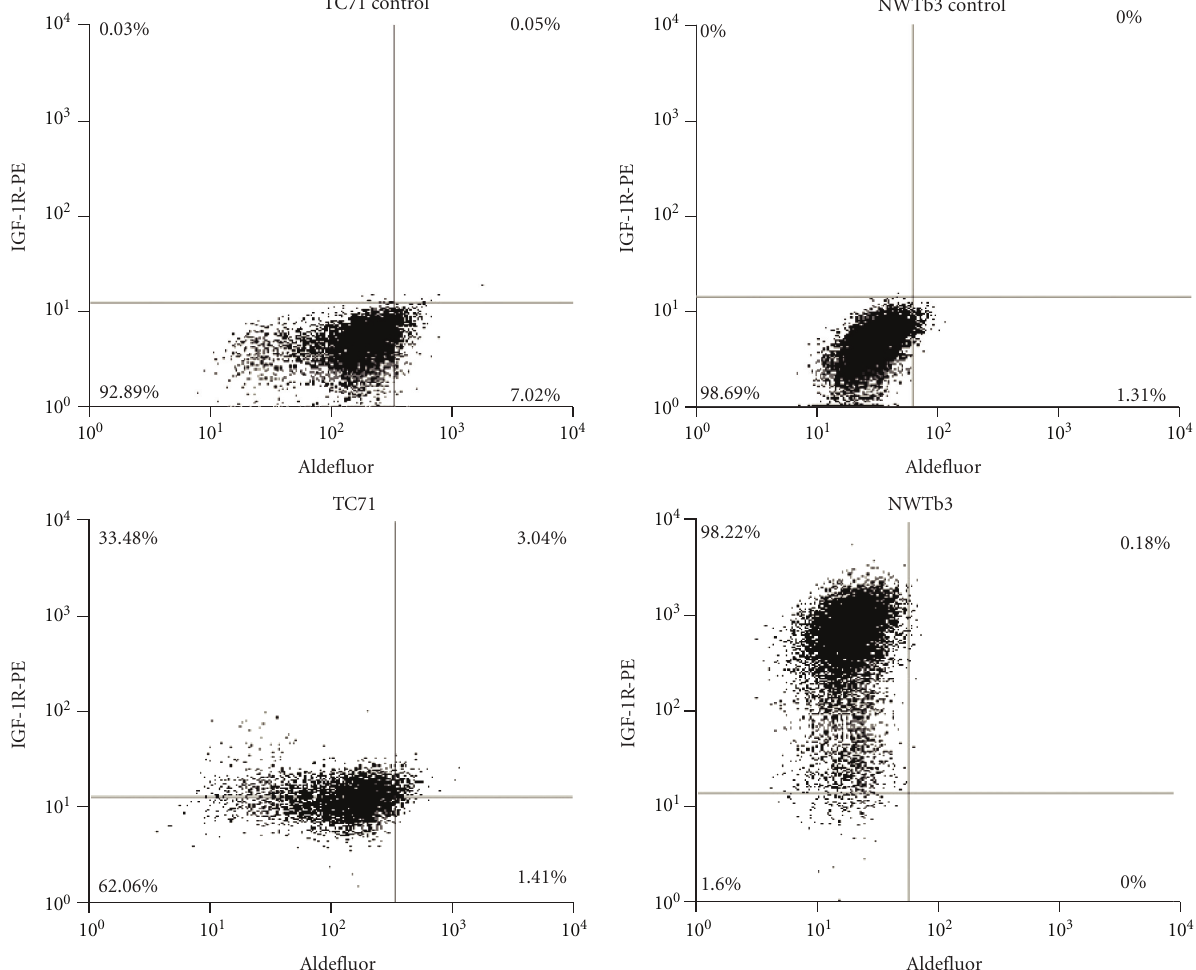
F 3: Gating of cells for �ow cytometric analysis of IGF-1R surface expression in TC�1 and NWTb3 cells stained with Alde�uor. Top: Alde�uor alone without IGF-IR-�E antibody. �ottom: Alde�uor plus IGF-1R-�E